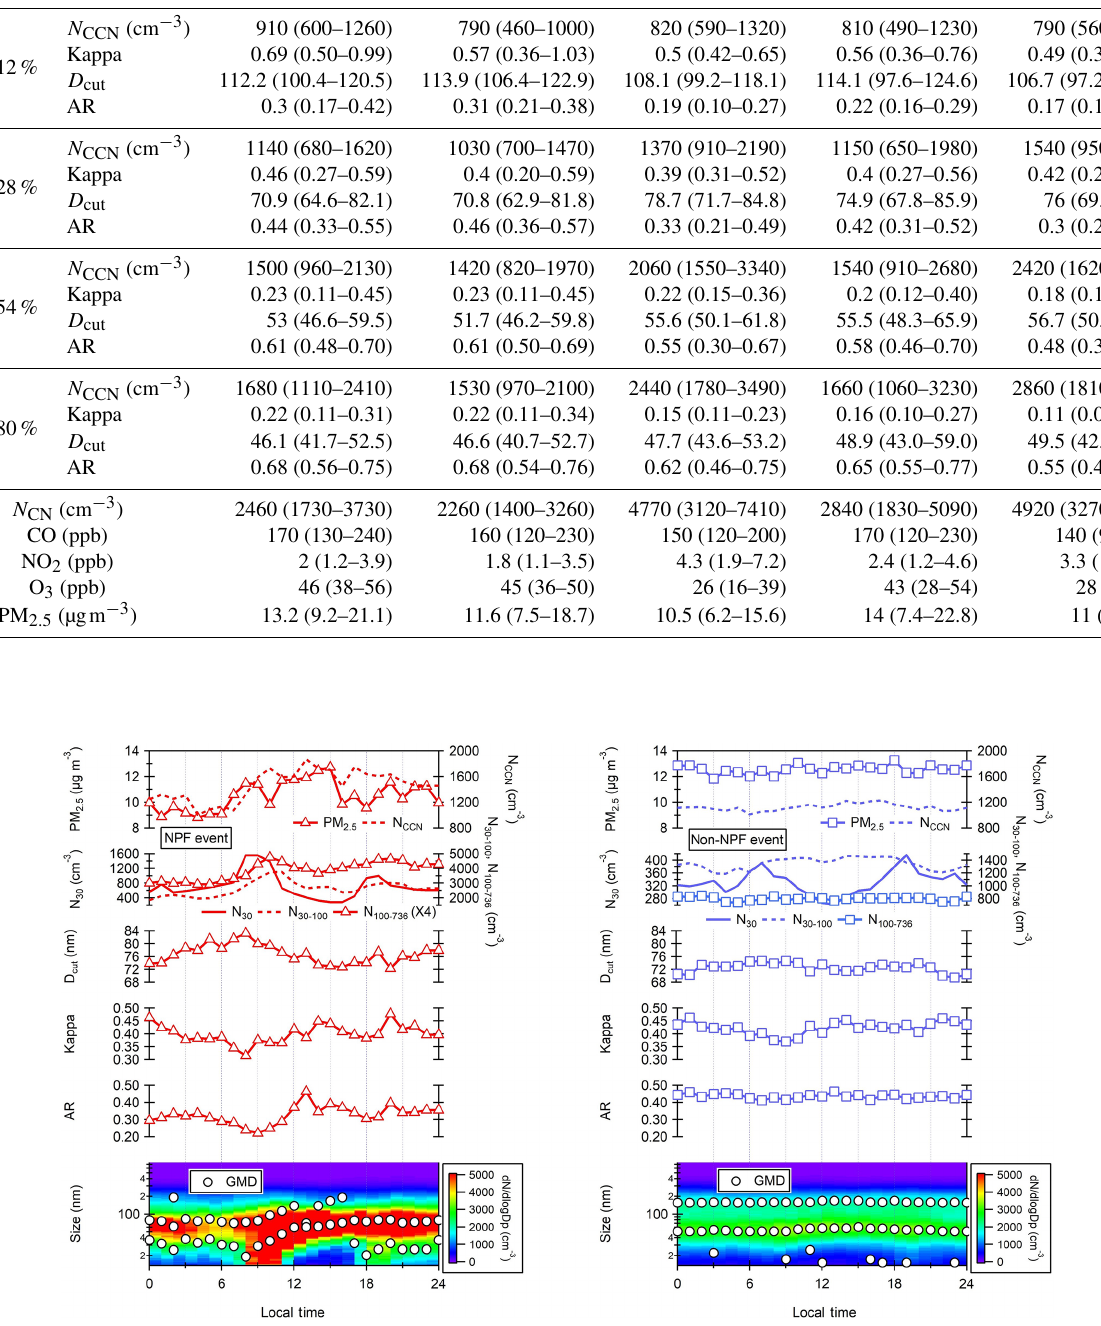
Figure 7. Diurnal variations of the particle size distribution and geometric mean diameter (GMD), activation ratio (AR), kappa ( κ ) value, activation diameter ( D cut ), particle number concentrations of N 30 , N 30 − 100 and N 100 − 736 , N CN , and N CCN as well as PM 2 . 5 for NPF and non-NPF events. CCN and related parameters were measured under an SS value of 0.28%. GMD values were calculated based on the multiple-curve-fitting result by the DO-FIT model for which one to three modes were defined depending on the particle size distribution